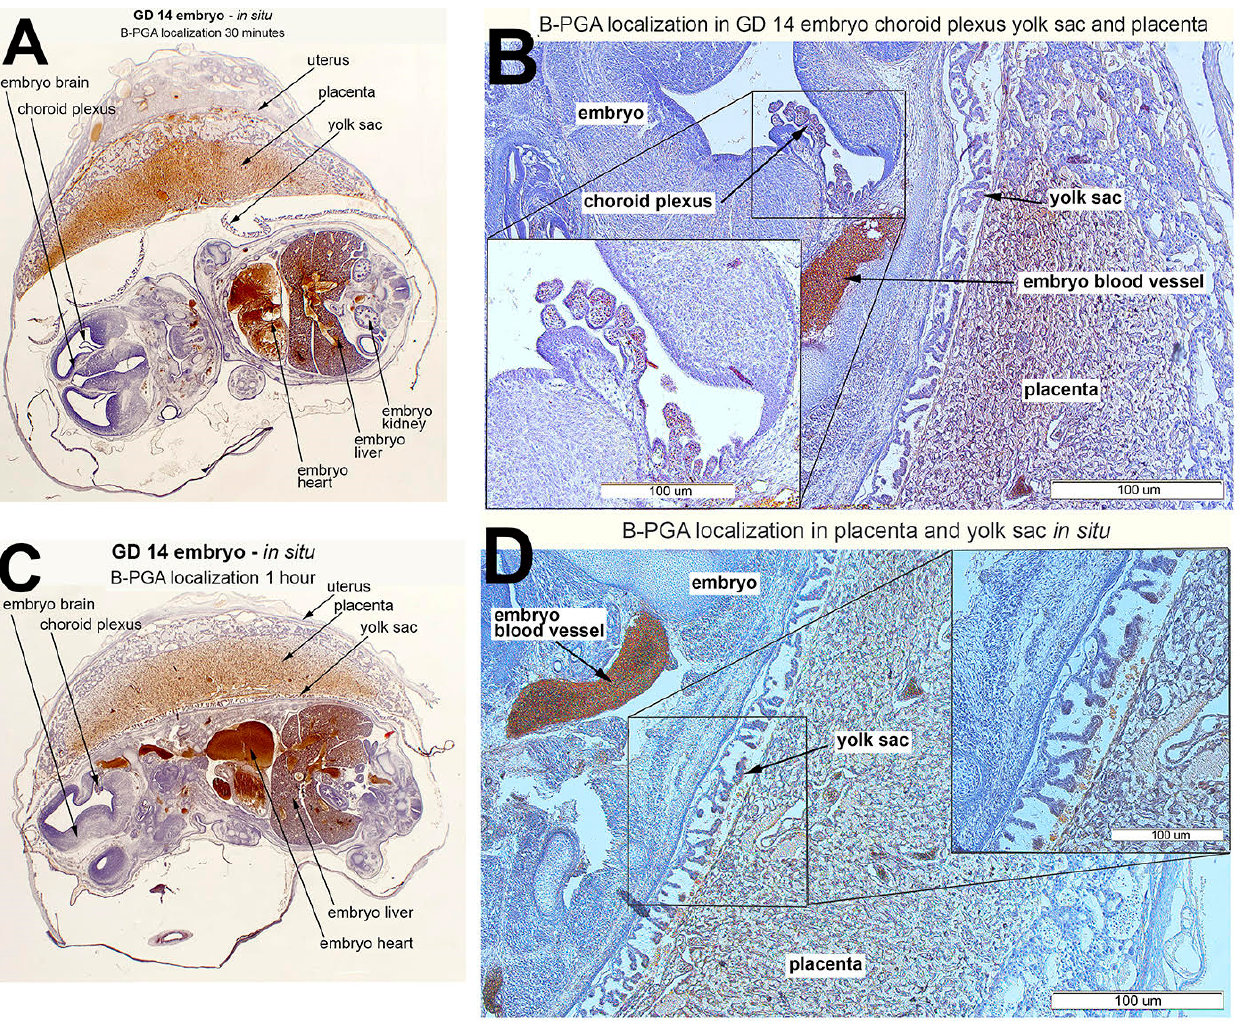
Figure 7. Distribution of biotin-conjugated folic acid (B-PGA) (brown staining) in the GD 14 placenta and embryo following IP injection of 25 µg of the compound. The rats were euthanized 30 ( A ) and 60 ( B – D ) minutes after B-PGA administration. Hematoxylin was used as the counterstain (blue/pur- ple).